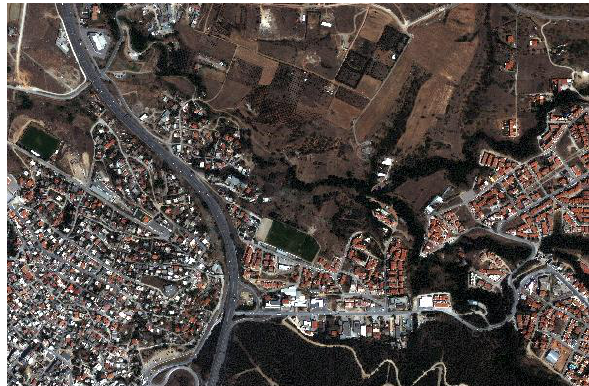
Figure 4. Subset of Quickbird image. Pixel